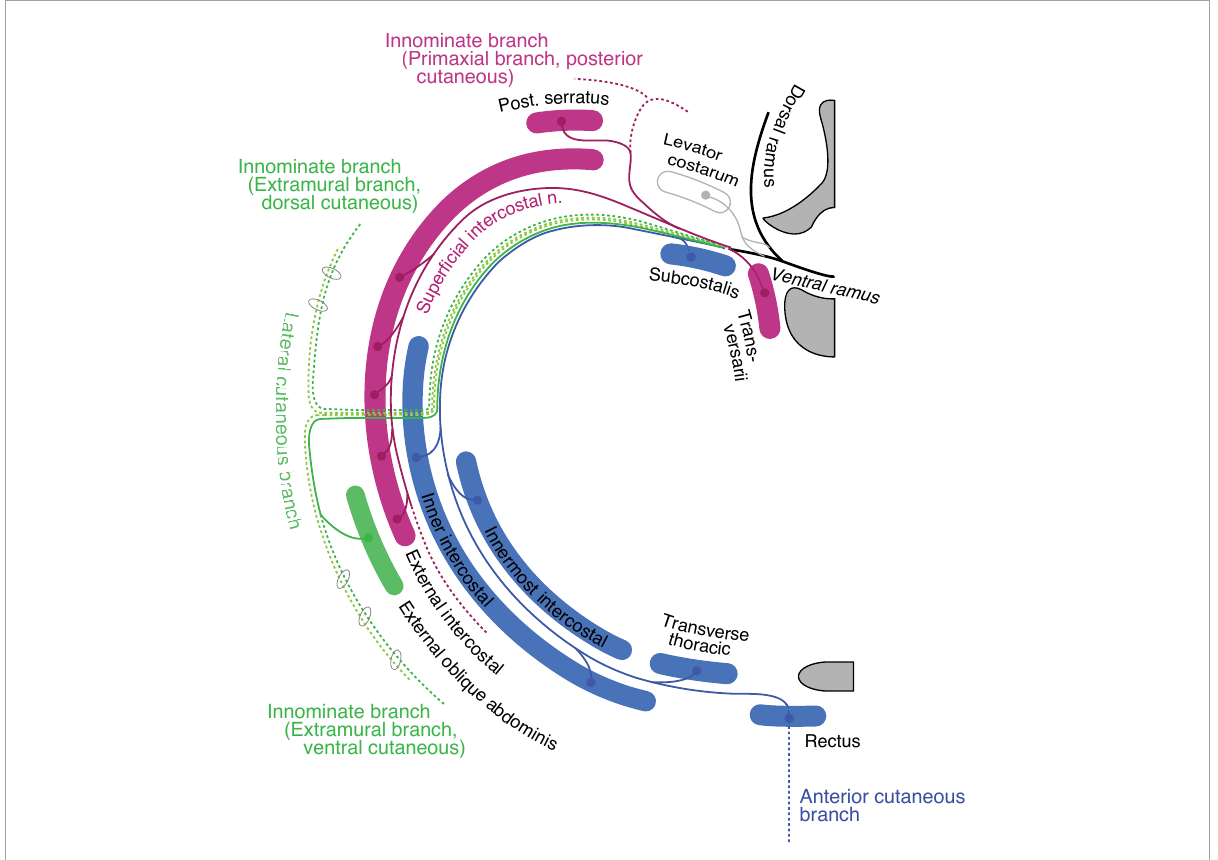
FIGURE9 Hypothetical innervation pattern of the three nerve components of the ICN in the mid-thoracic region. The purple color represents primaxial nerve branches and muscles. The blue color represents intramural branches and muscles within the body wall. The dark and light green lines are for the extramural and LCB, fasciculated in the thoracic region. The dotted lines are cutaneous branches. The vertebra (upper right) and sternum (lower right) are dark gray in color. Because the muscles and nerves are projected onto a single transverse plane (around Th5–6), not all of them are necessarily localized to the same transverse section as